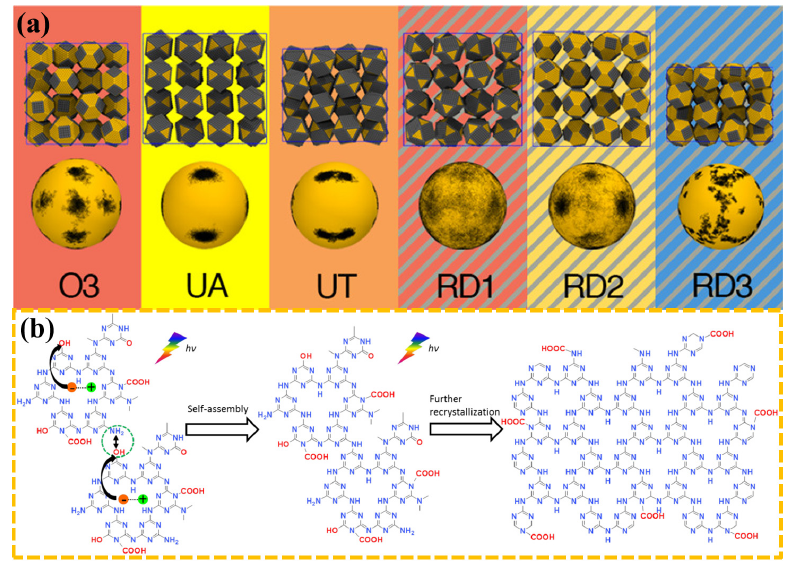
Figure 2. ( a ) Images of various QDs after molecular dynamics simulation [22]. Copyright 2019, J Am Chem Soc . ( b ) A schematic diagram of light-induced self-assembly of silicon nitride [23]. Copyright 2021, Angew Chem Int Ed Engl .